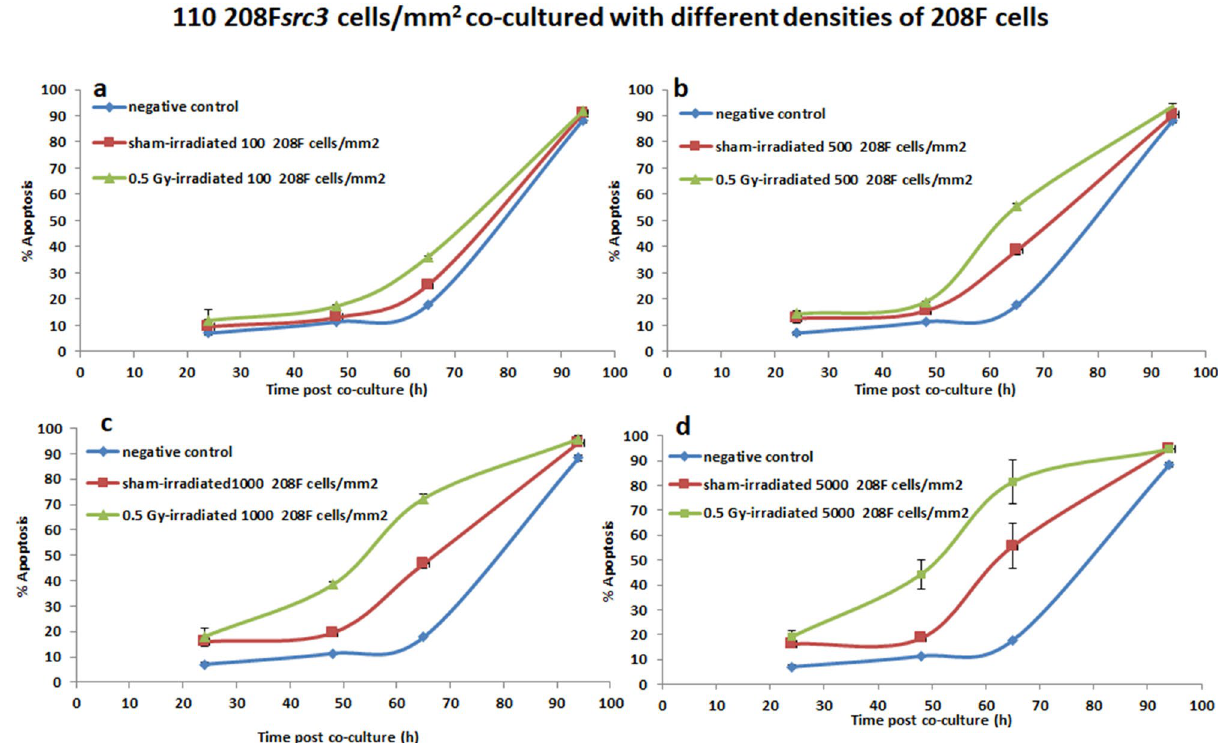
Figure 6. Varying 208F cells density and medium density 208F src3 cells. Cell density dependence apoptosis induction in transformed 208F src3 cells seeded at a seeding density of 110 cells/mm 2 cultured in the absence (negative control) or presence of 208F cells seeded at densities ( a ) 100, ( b ) 500, ( c ) 1000 and ( d ) 5000 cells/ mm 2 and either sham- or γ-irradiated with a dose of 0.5 Gy. Each data point is a mean value derived from three independent experiments. Error bars represent the standard deviation derived from three independent